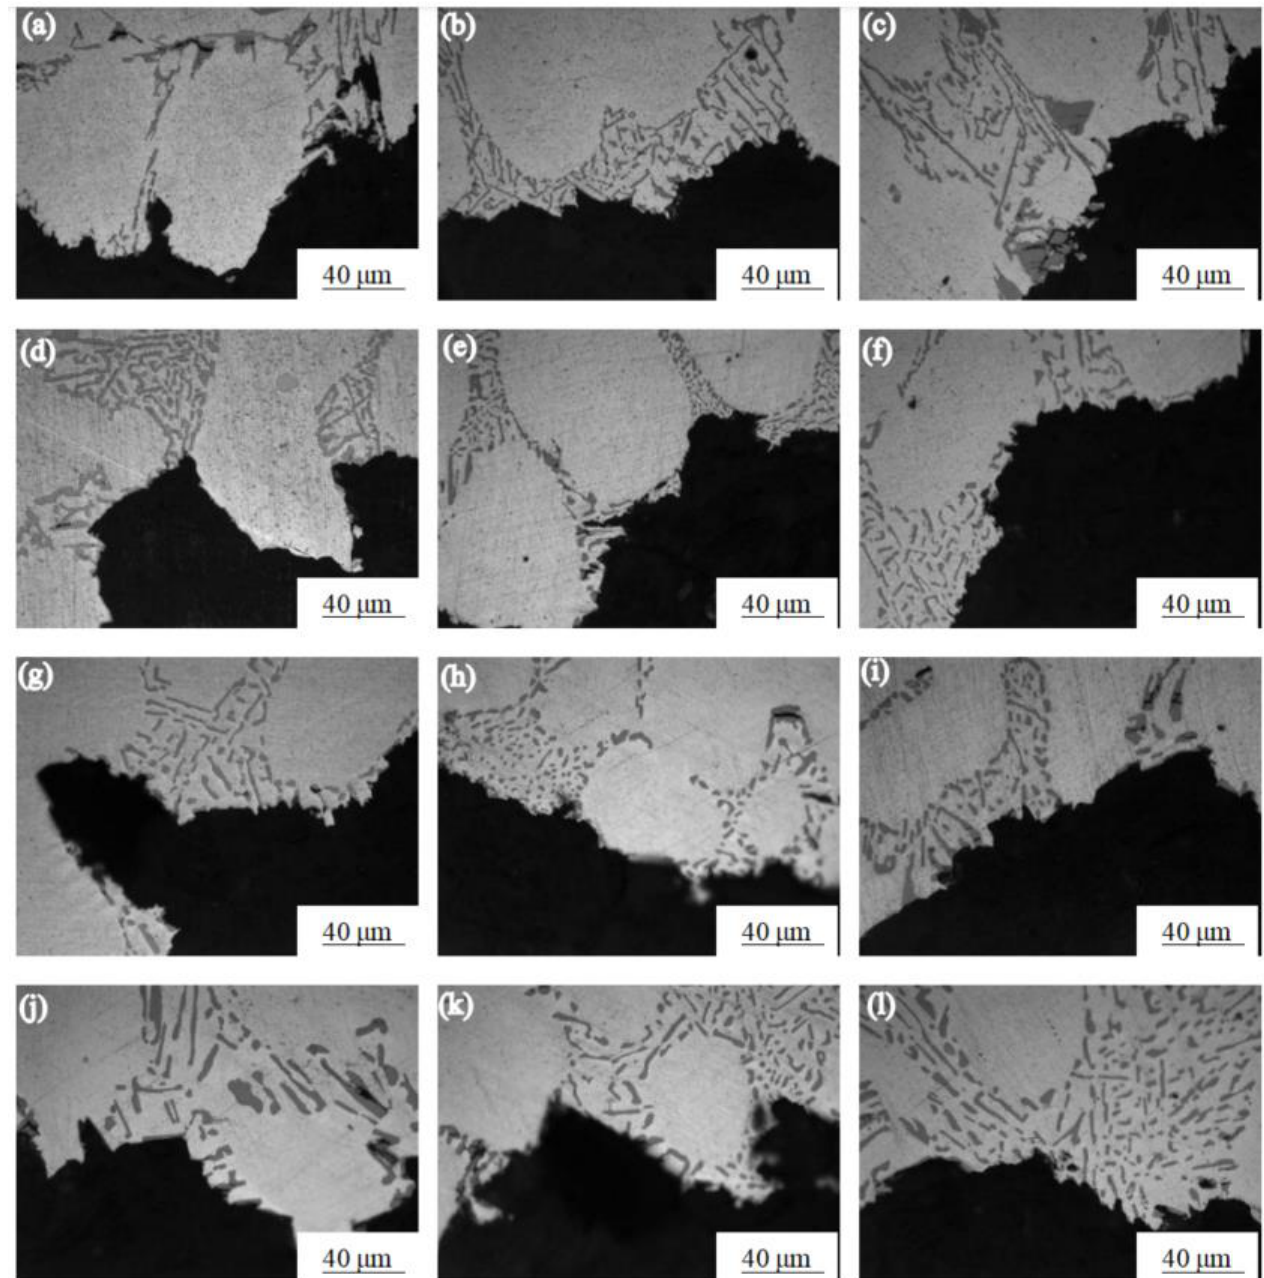
Figure 3. Fracture micro-structures of Al-7.0Si-0.3Mg alloy after different solution treatments: ( a ) 0 h, 20 °C; ( b ) 0 h, −20 °C ; ( c ) 0 h, −60 °C ; ( d ) 6 h, 20 °C; ( e ) 6 h, −20 °C ; ( f ) 6 h, −60 °C ; ( g ) 10 h, 20 °C; 20 ◦ C; ( b ) 0 h, − 20 ◦ C; ( c ) 0 h, − 60 ◦ C; ( d ) 6 h, 20 ◦ C; ( e ) 6 h, − 20 ◦ C; ( f ) 6 h, − 60 ◦ C; ( g ) 10 h, 20 ◦ C; ( h ) 10 h, −20 °C ; ( i ) 10 h, −60 °C ; ( j ) 15 h, 20 °C; ( k ) 15 h, −20 °C ; ( l ) 15 h, −60 °C . ( h ) 10 h, − 20 ◦ C; ( i ) 10 h, − 60 ◦ C; ( j ) 15 h, 20 ◦ C; ( k ) 15 h, − 20 ◦ C; ( l ) 15 h, − 60 ◦